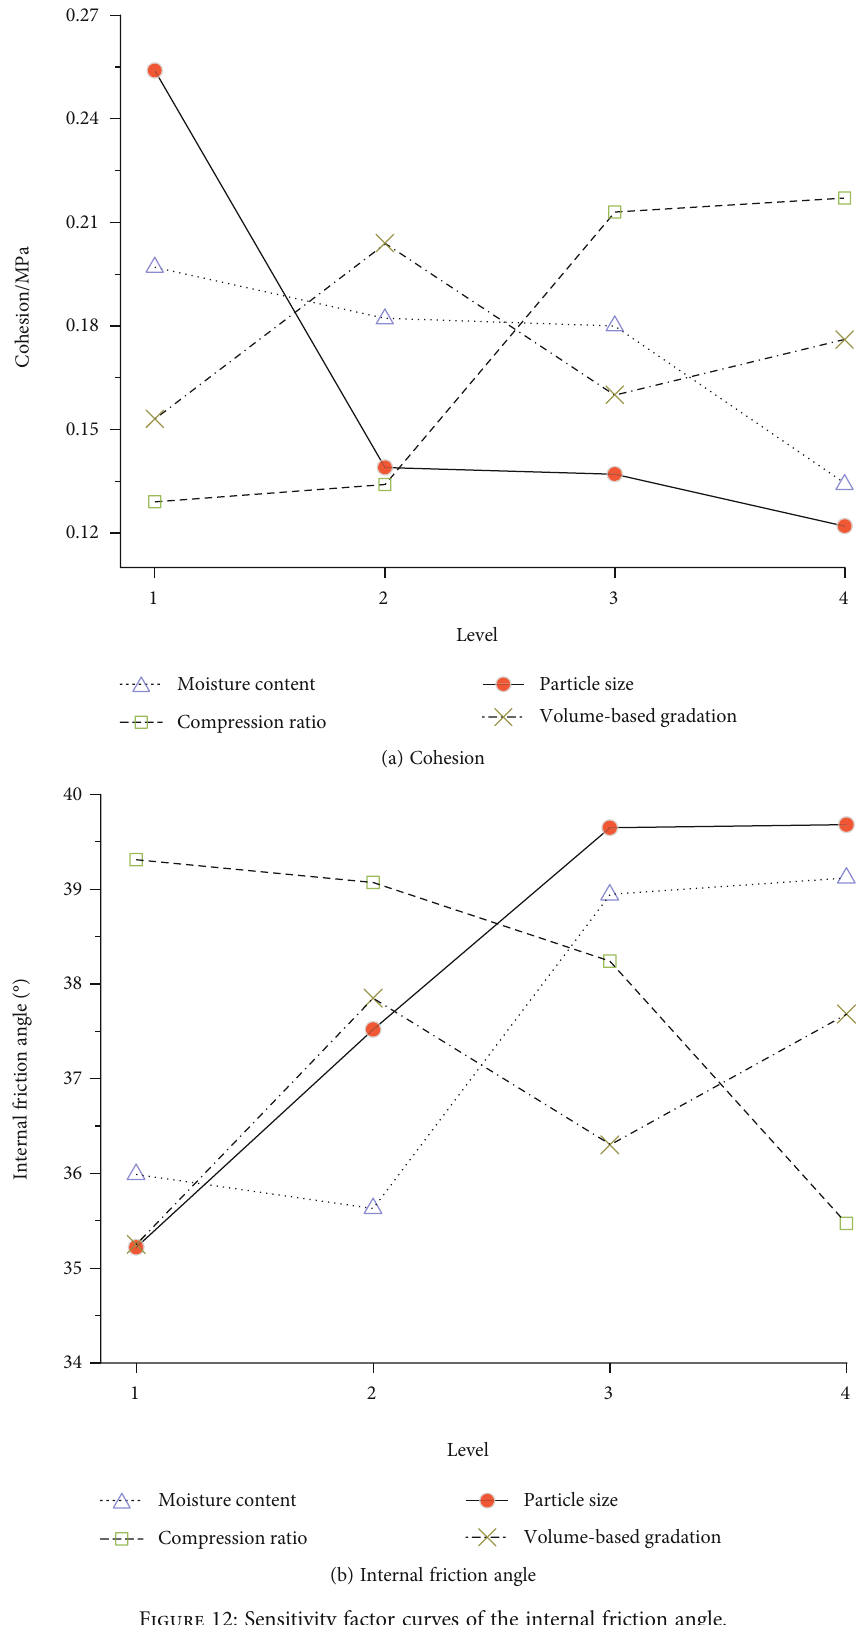
Figure 12: Sensitivity factor curves of the internal friction